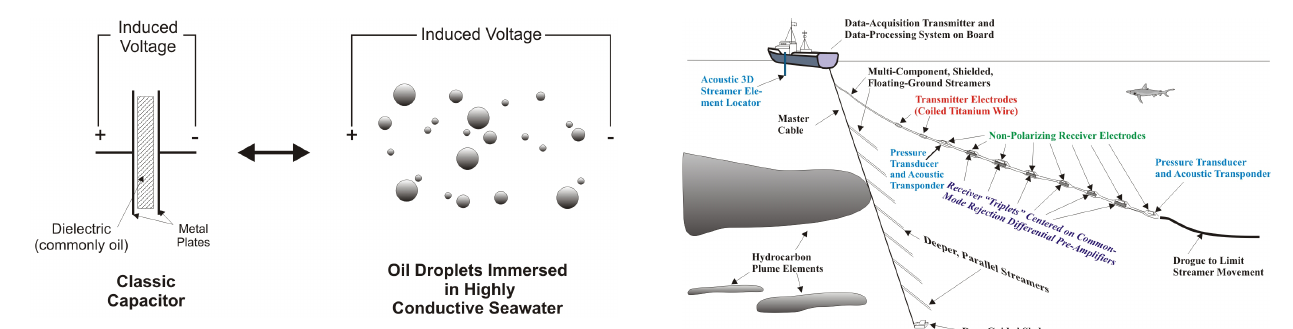
Fig. 2. One of several possible seawater capacitance-measuring configurations. A single-cable version has been used to map il- menite (FeTiO 3 ) beneath the seafloor in the Gulf of Mexico, off the coast of Georgia (USA), and offshore of South Africa. This ship-towed streamer array would continuously sample a plane up to 40m wide through the deep ocean, and towing the array in lawn- mower fashion would quickly provide a 3-D image of the hydrocar- bon plume elements. Repeat surveys would then provide informa- tion on plume movement, and by tracking frequency distribution of the transmitter-receiver phase shift, its biodegradation and evolution over